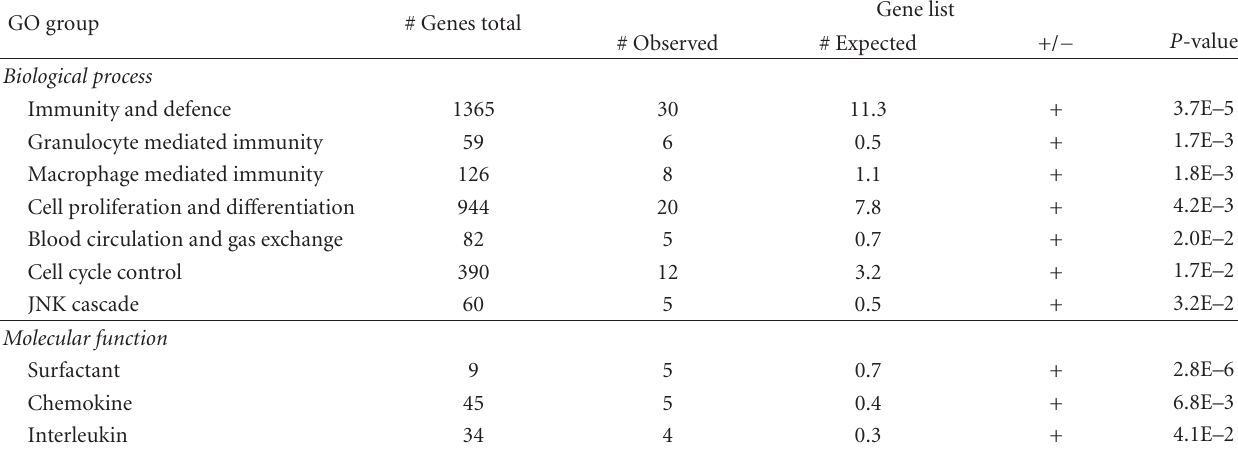
Table 3: GO groups with significant enrichment, based on a comparison of the top-210 significant genes di ff erentially expressed between metastases and primary tumours against all genes present on the microarray. The number of genes in the total list and observed and expected number of genes in the gene list that map to the GO group are shown. + or − signs indicate over- or underrepresentation, respectively, of this GO group. P -values were Bonferroni corrected for multiple testing, P -value <